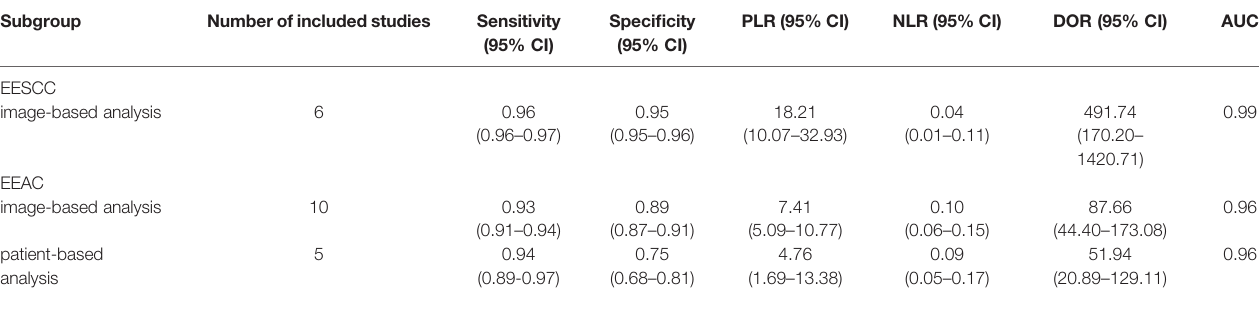
TABLE 3 | Summary of subgroup analysis based on pathologic type.